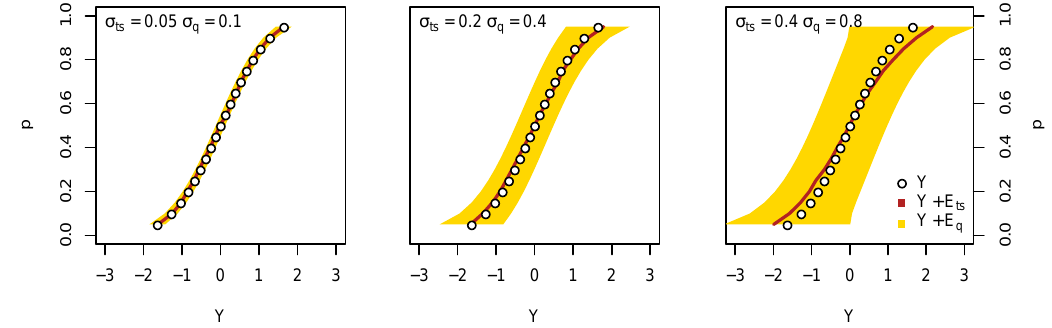
Figure 7. A synthetic example for the different effect of increasing time series and quantile uncertainty on the CDF of Y + E : Y is a standard normal distribution, E ts is an i.i.d. normal time series error and E q is a normal quantile error. The uncertainty intervals were derived from 2000 realisations, the time series length was 2000 as